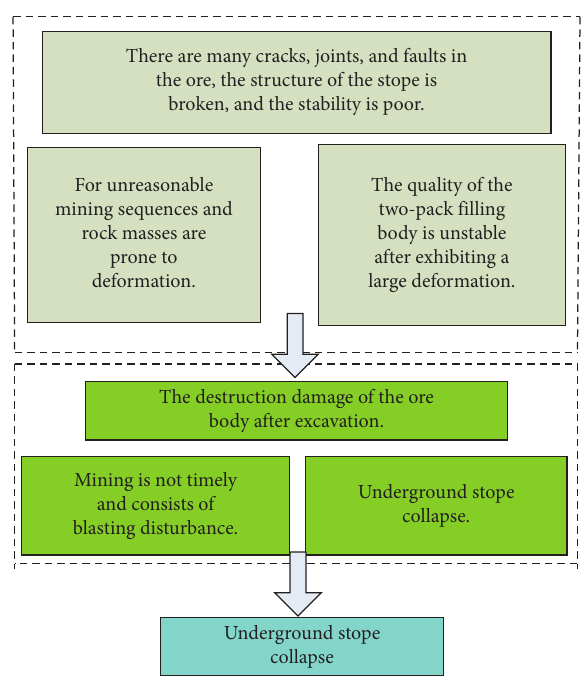
Figure 2: The causes of steady mine rock collapse.